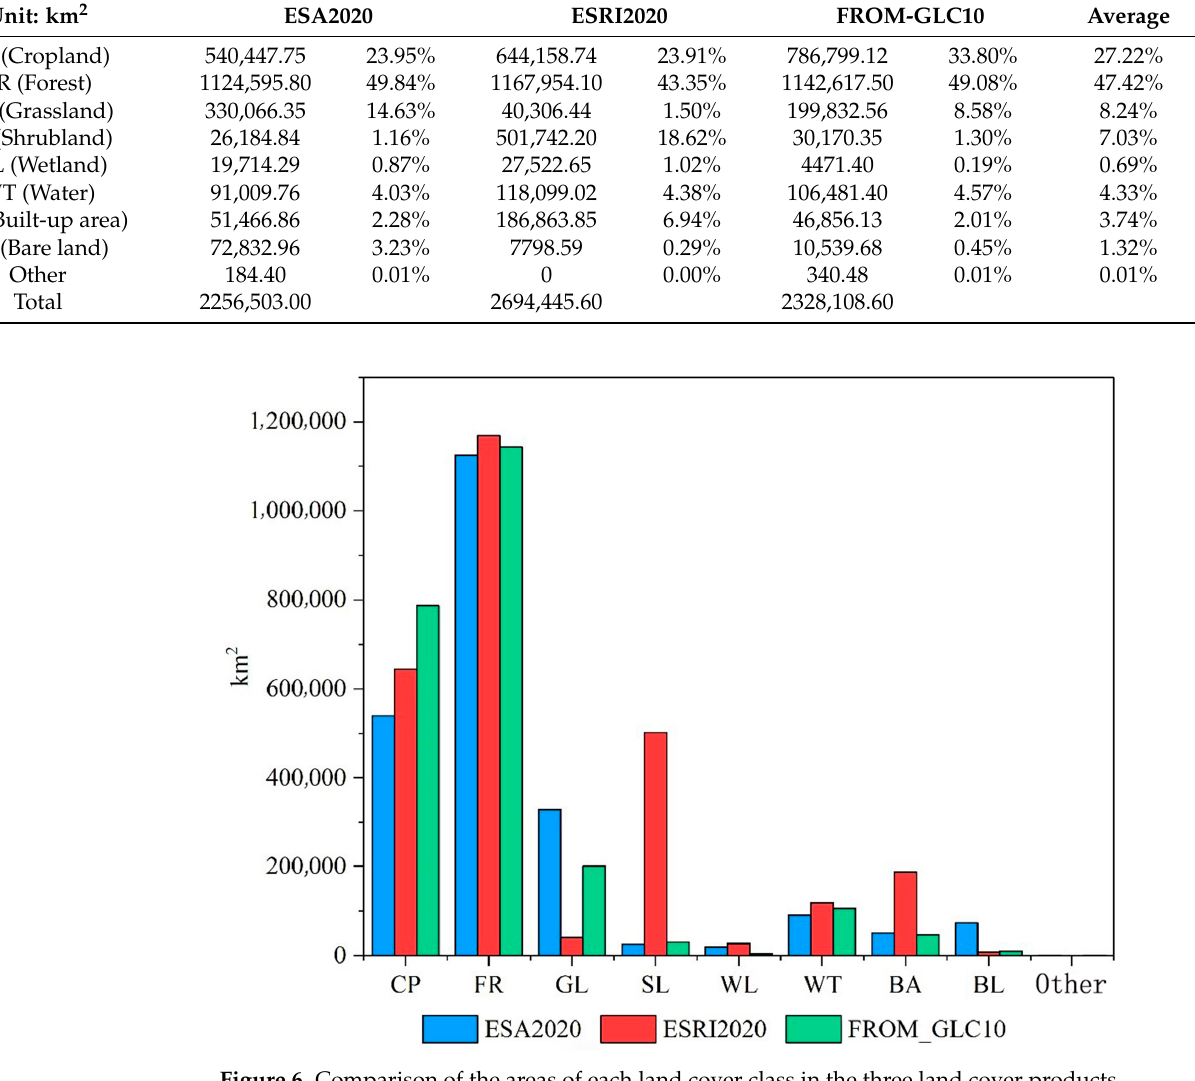
Figure 6. Comparison of the areas of each land cover class in the three land cover products. Table 6. The areas of the different land cover classes in the three